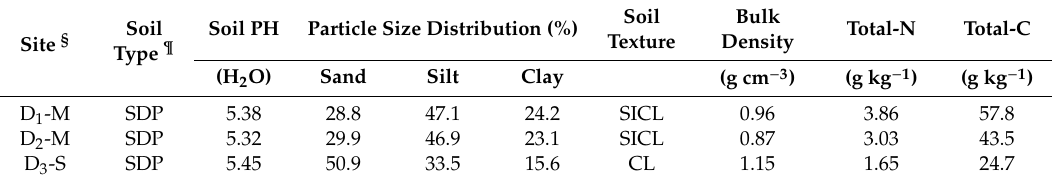
Table 1. Some physical and chemical characteristics of the investigated paddy field soils (initial soil at 0–10 cm depth).